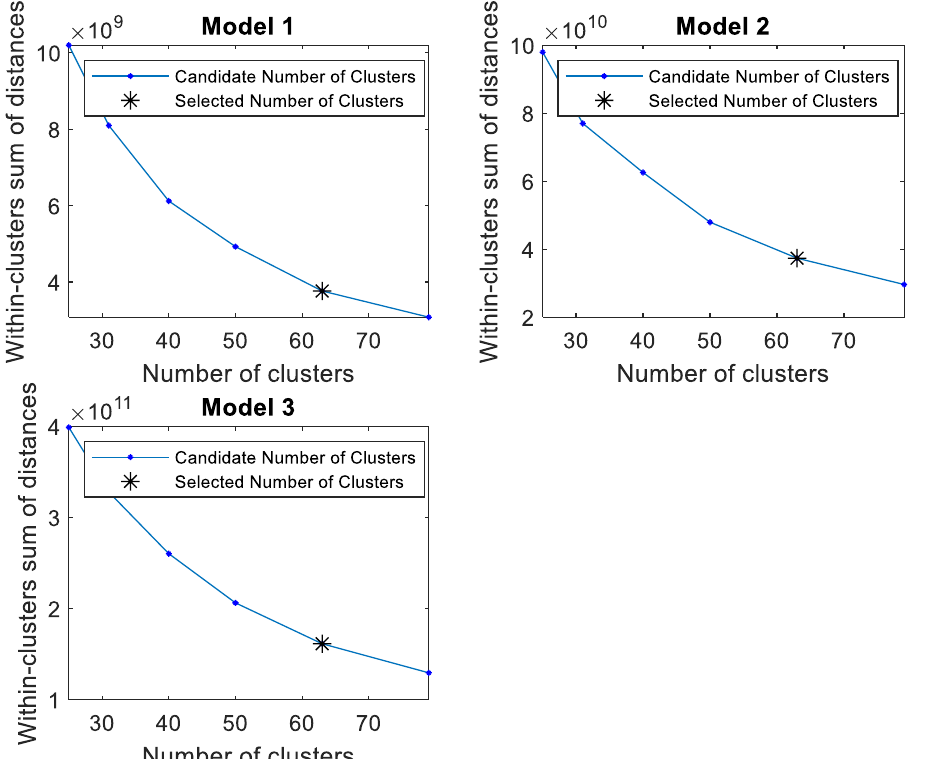
Figure 7. Number of clusters selection. Our method selects 63 clusters for the first, second, and third models.